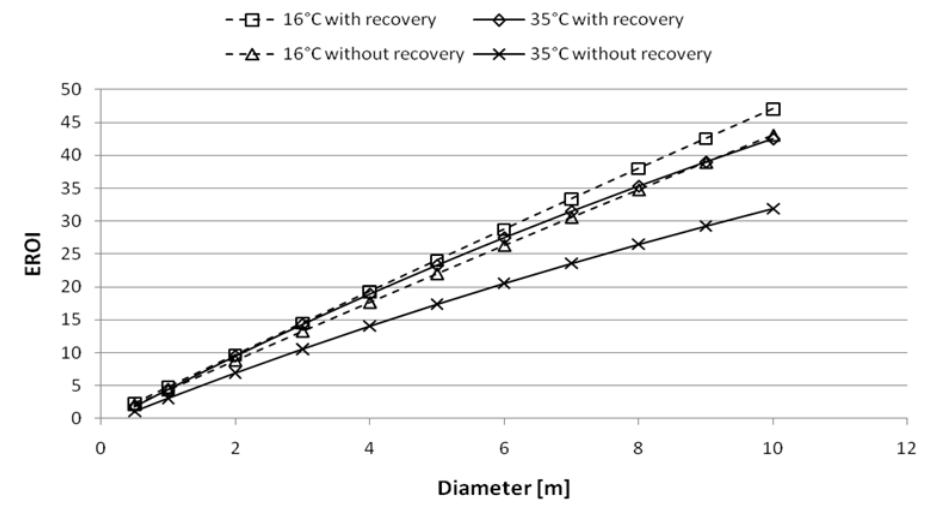
Figure 14. Energy Return on Investment of anaerobic digestion for bioH 2 + CH 4 production; two situations were considered 16 and 35 °C with and without heat recovery